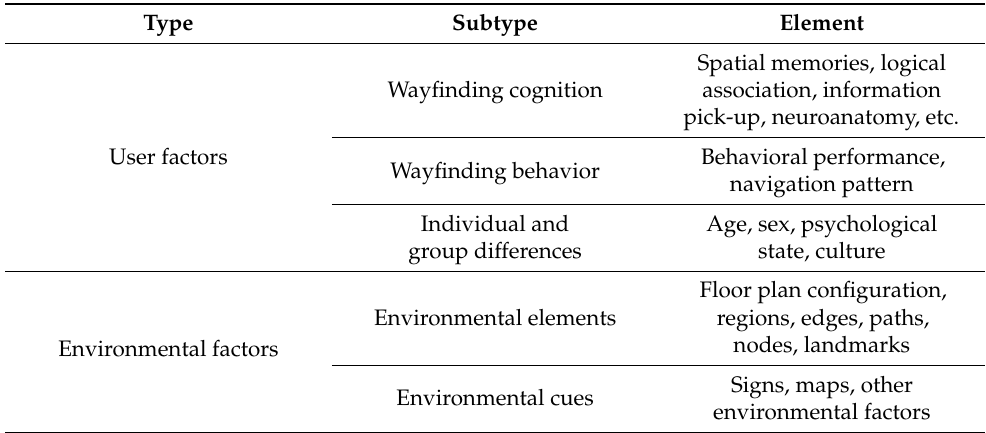
Table 1. Types of wayfinding factors.